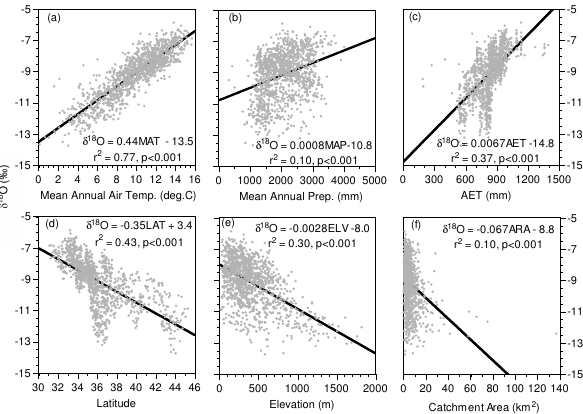
Figure 7. Correlations of δ 18 O and environmental or geographical